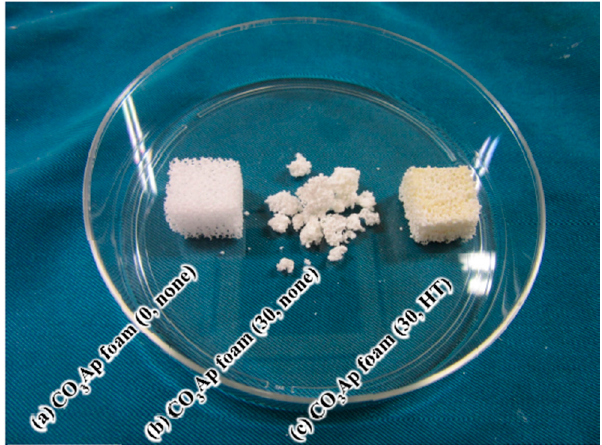
Figure 6. Photographs of CO 3 Ap foams when immersed in the saline solution at 37 °C for 24 h: ( a ) CO 3 Ap foam (0, none); ( b ) CO 3 Ap foam (30, none); and ( c ) CO 3 Ap foam (30, HT).